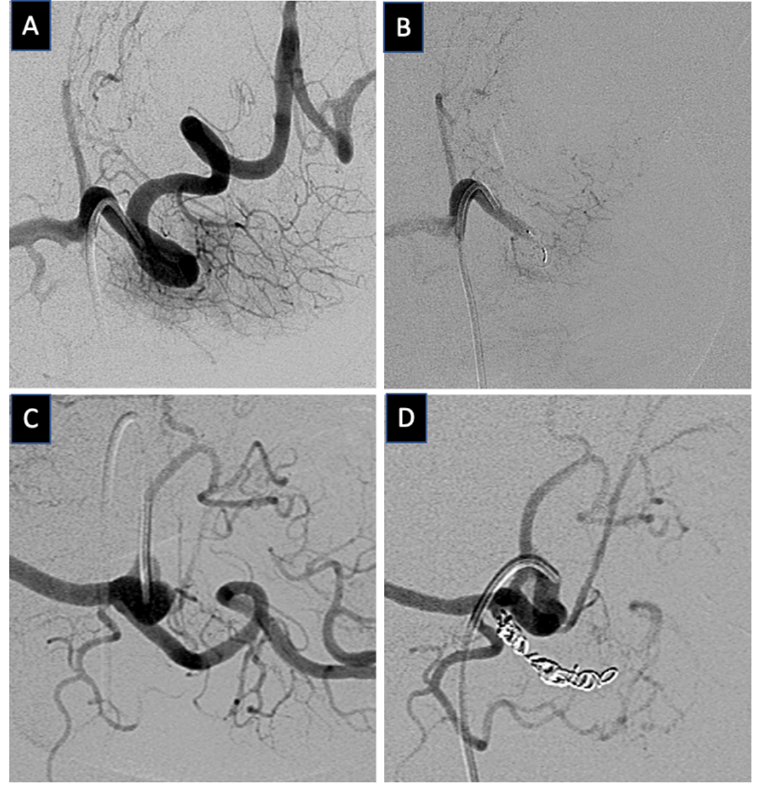
Figure 1. Selective angiographic images during the splenic artery embolization procedures: ( A ) pre-embolization and ( B ) post-embolization angiogram using Caterpillar Arterial Embolization Device; ( C ) pre-embolization and ( D ) post-embolization angiogram using fibered embolization